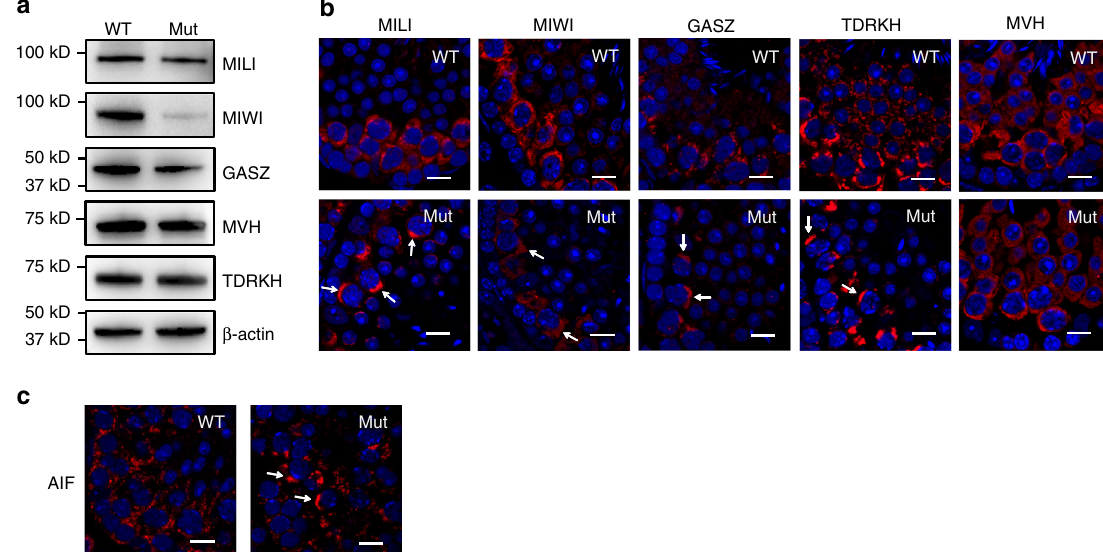
Fig. 3 Pnldc1 mutation causes mitochondria disorder. a Expression of TDRKH, MILI, MIWI, GASZ, and MVH in WT and Pnldc1 Mut (Mut-1) testes revealed by western blotting. β -actin is a loading control. b Aggregation of TDRKH, MILI, MIWI, and GASZ in Pnldc1 Mut spermatocytes. Immunostaining was performed using indicated antibodies on adult testis sections from WT and Pnldc1 Mut (Mut-1) mice. DNA ( blue ) is stained with DAPI. Protein aggregations are indicated by arrows . Scale bar , 10 μ m. c Conglomeration of mitochondria in Pnldc1 Mut testes. Immunostaining of WT and Pnldc1 Mut (Mut-1) testis sections with an antibody against AIF, a mitochondrial marker. DNA ( blue ) is stained with DAPI. Conglomeration of mitochondria is indicated by arrows . Scale bar